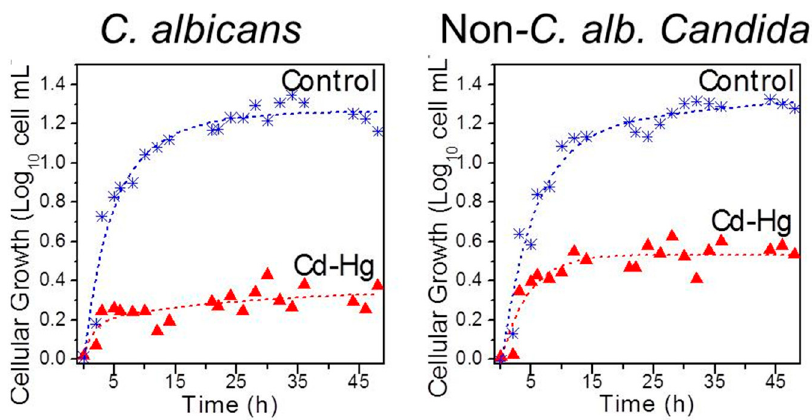
Figure 2. Growth curves of Candida albicans and representative non- C. albicans species of Candida ( C. glabrata and C. krusei ) when exposed to 1.0 mM Cd–Hg mixture. Non metal-exposed samples are shown as controls.